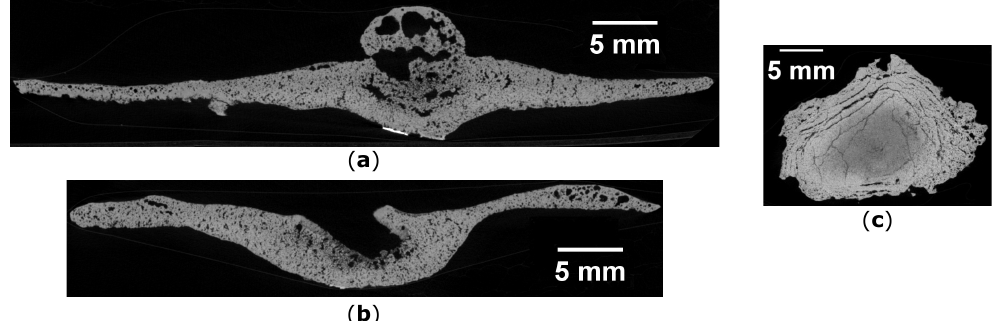
Figure 6. Cross-sectional CT images of selected rafts, where the raft’s top is facing upwards. ( a ) Raft from bulk alumina with holding time 60 s. ( b ) Raft from bulk alumina with holding time 180 s. ( c ) Raft from fine alumina with holding time 60 s.